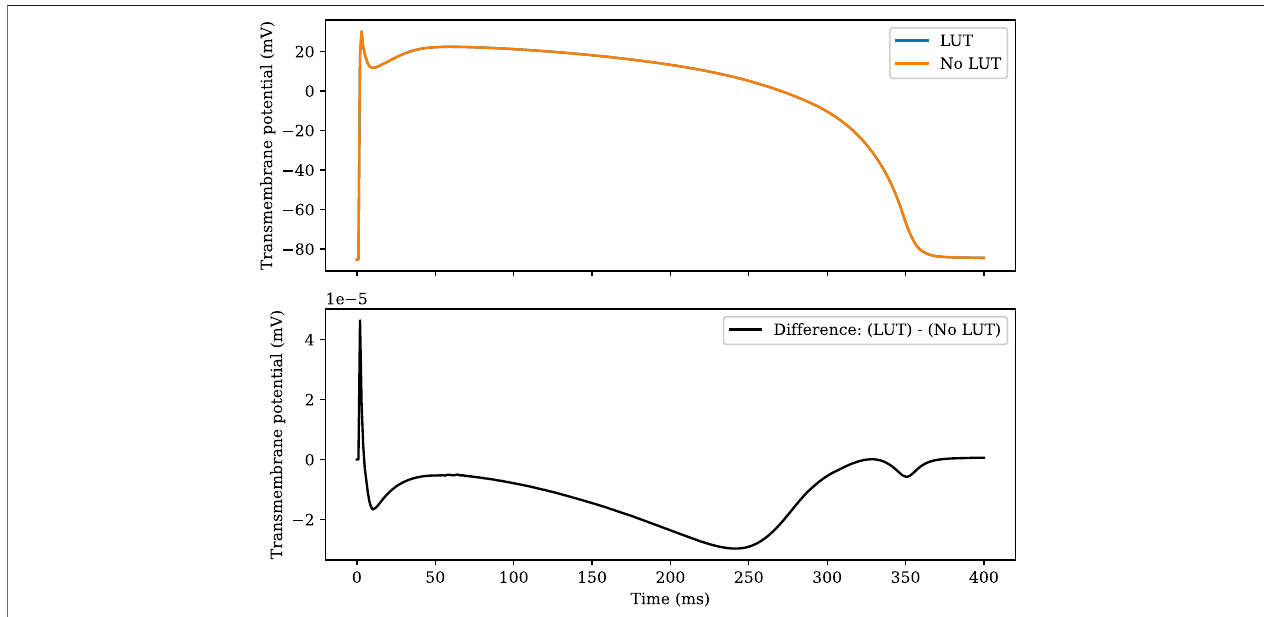
FIGURE 1 | Comparison of the TP06 model solved with and without the use of lookup tables. The RL scheme is used with Δ t = 1 µs. In the upper plot, the two numerical solutions cannot be distinguished by eye. The RRMS error of the LUT solution compared with the non-LUT solution is 1.36 × 10 – 7 .